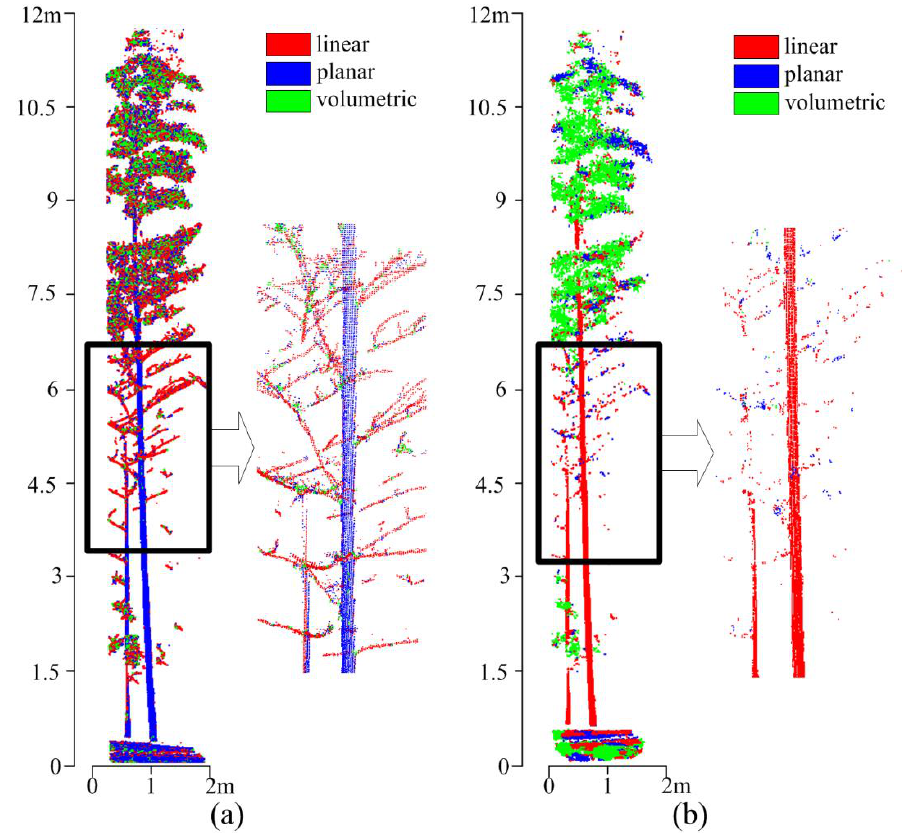
Figure 5. An example of two-scale classification: ( a ) classification results at the first scale; and ( b ) classification results at the second